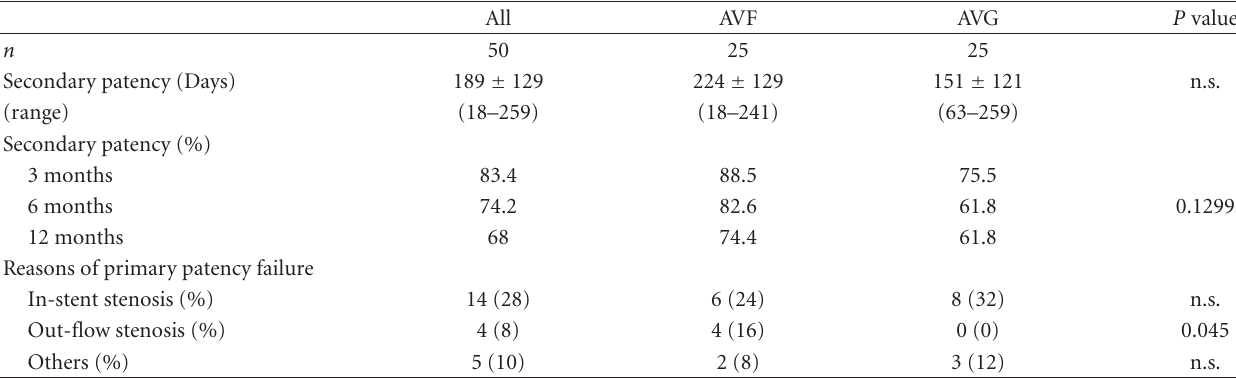
Table 3: Secondary patency for SMART stent placement in AVF and AVG cases.There was no significant di ff erence in secondary patency rates between AVF and AVG cases, but patency in AVG showed inferior to AVF. The rate of outflow stenosis onset was significantly higher in AVF cases ( P = 0 . 045).